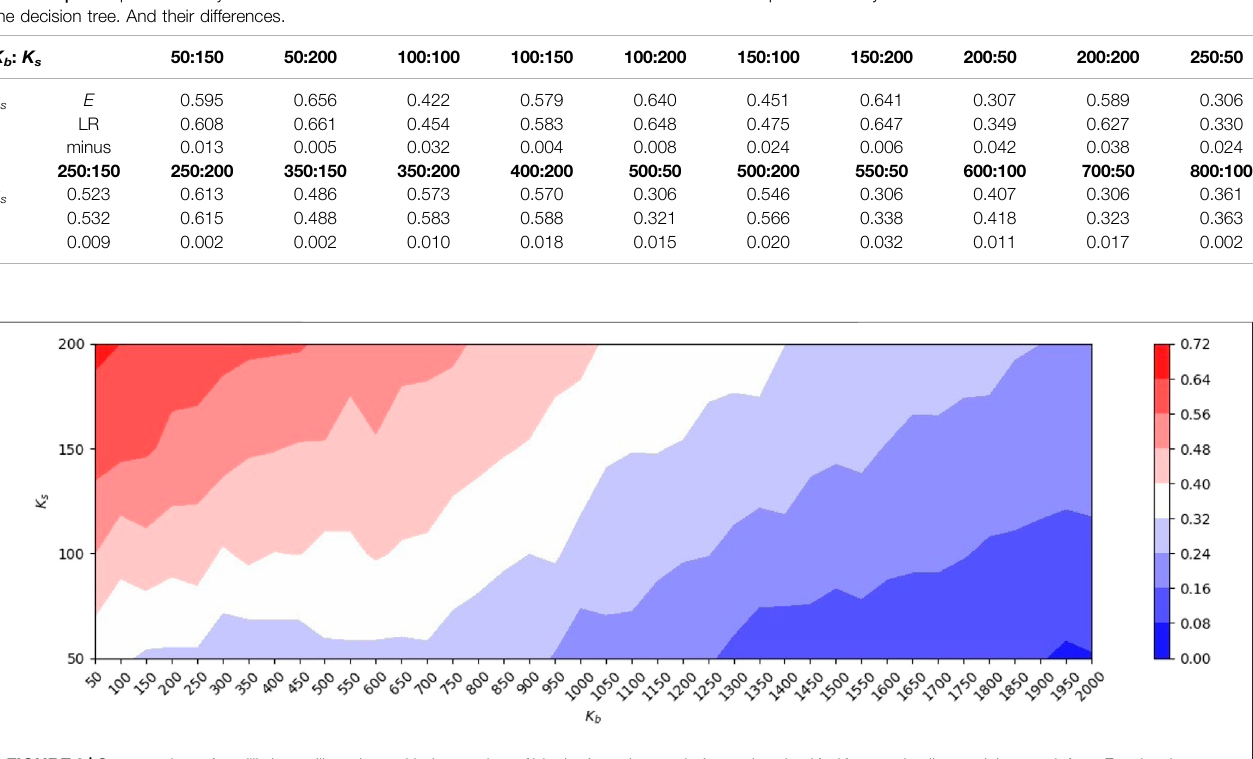
Frontiers in Physics |